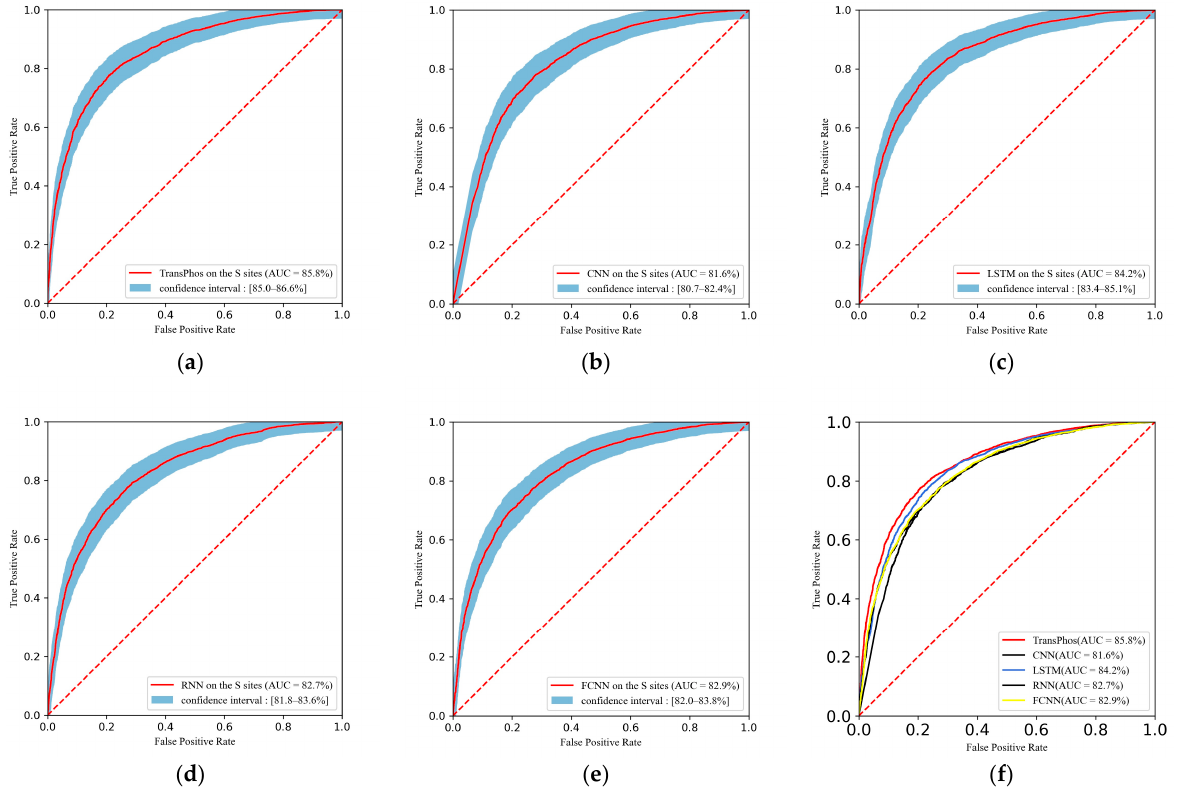
Figure 1. ROC curves containing 95% confidence intervals for different deep learning models on the S sites of the training dataset P.ELM, 10-fold cross validation was used. Area Under Curve (AUC) is defined as the area under the ROC curve to measure the performance of the model. ( a ) ROC curve of the TransPhos model; ( b ) ROC curve of the Convolution neural network (CNN) model. ( c ) ROC curve of the Long and short term memory network (LSTM) model. ( d ) ROC curve of the Recurrent Neural Networks (RNN) model. ( e ) ROC curve of the Fully connected neural networks (FCNN) model. ( f ) Performance comparison on the S sites of the P.ELM